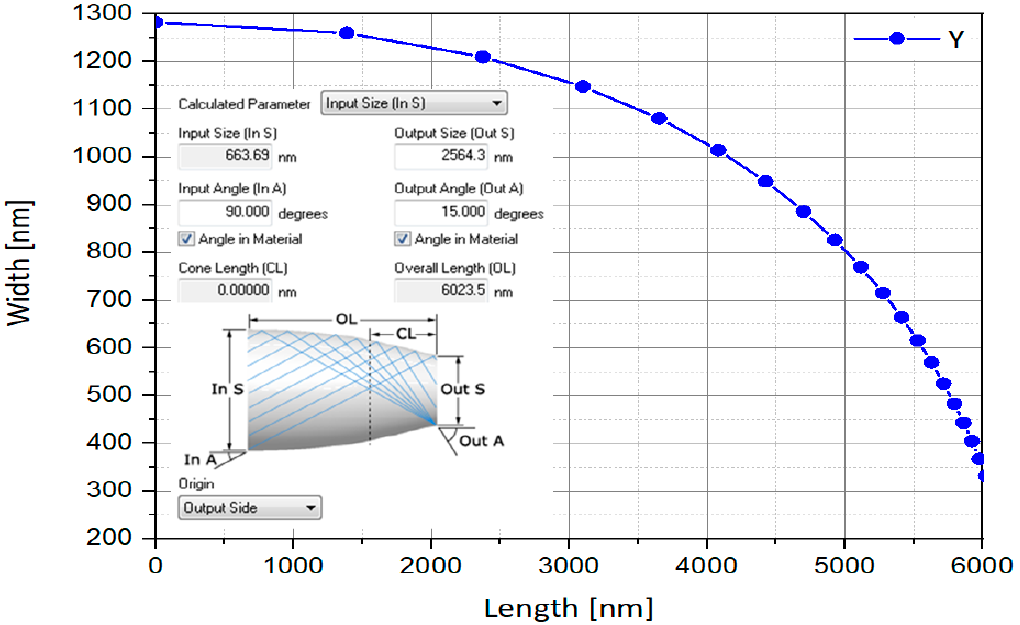
Figure 13. The optimized CPC profile.